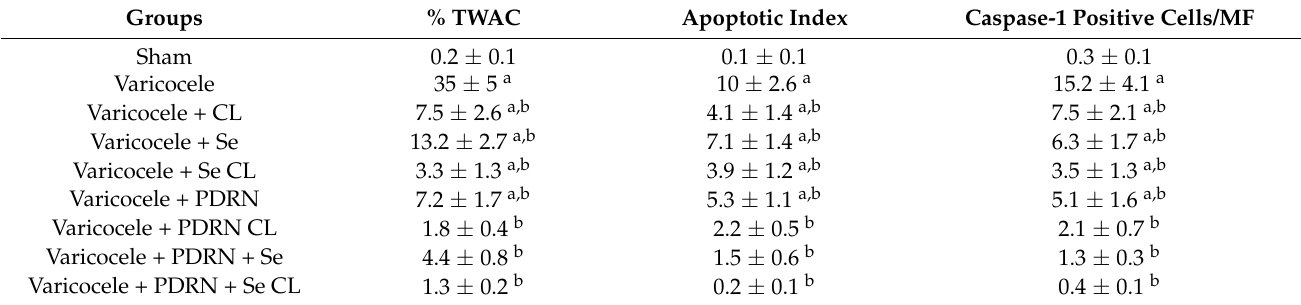
Table 3. Effects on %TWAC (percentage of tubules with apoptotic cells), on the apoptotic index (mean number of TUNEL-positive cells per tubule), and on the number of caspase-1 positive cells/MF (microscopic field) as induced by Se (0.4 mg/kg i.p.), PDRN (8 mg/Kg/day i.p.) and Se (0.4 mg/kg i.p.) plus PDRN (8 mg/Kg/ day i.p.) in varicocele rats as compared to sham and varicocele rats. Se = seleno-L-methionine; PDRN = polydeoxyribonucleotide; CL = contralateral testis. All values are expressed as mean ± SE; n = 7 animals for each group. a p < 0.05 vs. sham; b p < 0.05 vs.